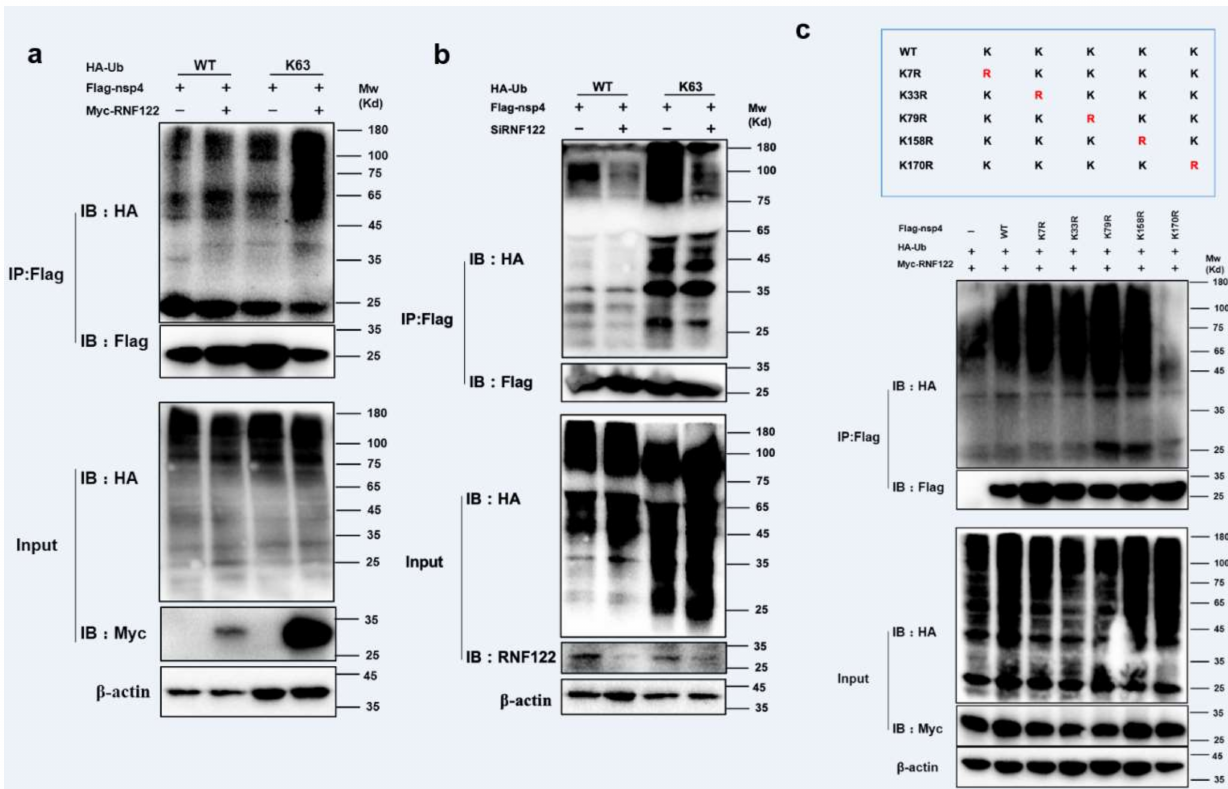
Figure 7. RNF122 performed K63-linked ubiquitination lysine of PRRSV nsp4 at position 170. ( a ) HEK293T cells were co-transfected with Myc-RNF122, Flag-nsp4 and HA-Ub (WT) or HA-Ub (K63). Flag Beads were used for CO-IP 24 h after transfection and further detected by Western blotting with an anti-HA, an anti-Flag antibody and an anti-Myc antibody, respectively. ( b ) HEK293T cells were co-transfected with SiRNF122, Flag-nsp4 and HA-Ub (WT) or HA-Ub (K63). Flag Beads were used for CO-IP 24 h after transfection and further detected by Western blotting with an anti-HA, an anti-Flag antibody and an anti-RNF122 antibody, respectively. ( c ) HEK293T cells were co-transfected with Myc-RNF122, HA-Ub (WT) and Flag-nsp4, Flag-nsp4(K7R), Flag-nsp4(K33R), Flag-nsp4(K79R), Flag-nsp4(K158R), Flag-nsp4(K170R) or not. Flag Beads were used for CO-IP 24 h after transfection and further detected by Western blotting with an anti-HA, an anti-Flag antibody and an anti-Myc antibody,